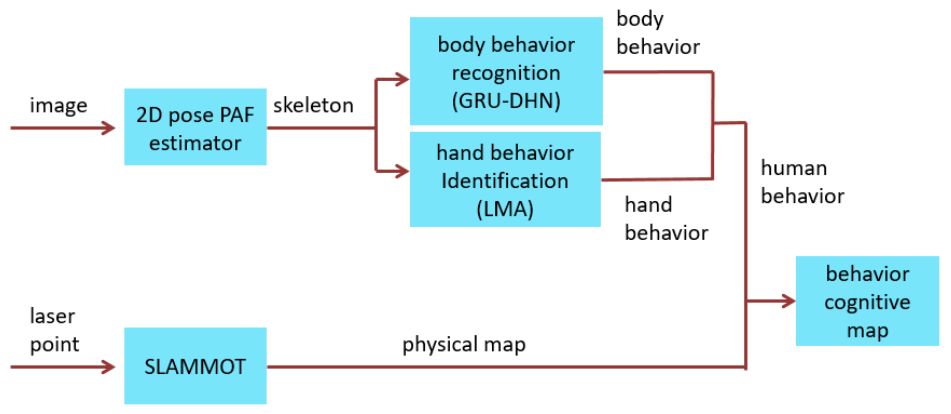
Figure 1. Structure of a behavior cognitive map.